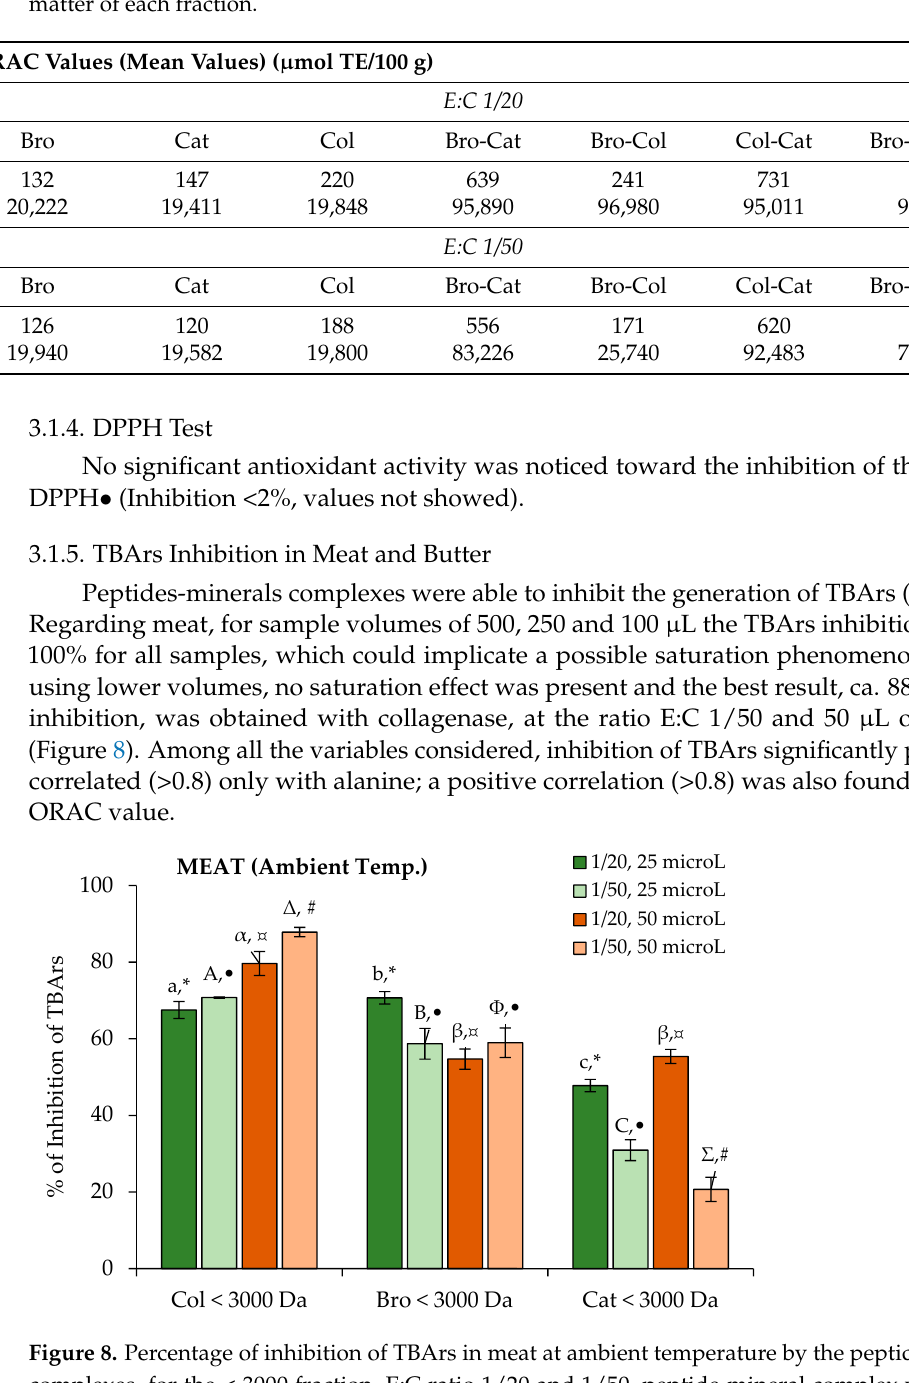
Table 4. ORAC values at the E:C ratio 1/20 and 1/50, for 100 g of solution and for 100 g of solid matter of each fraction.